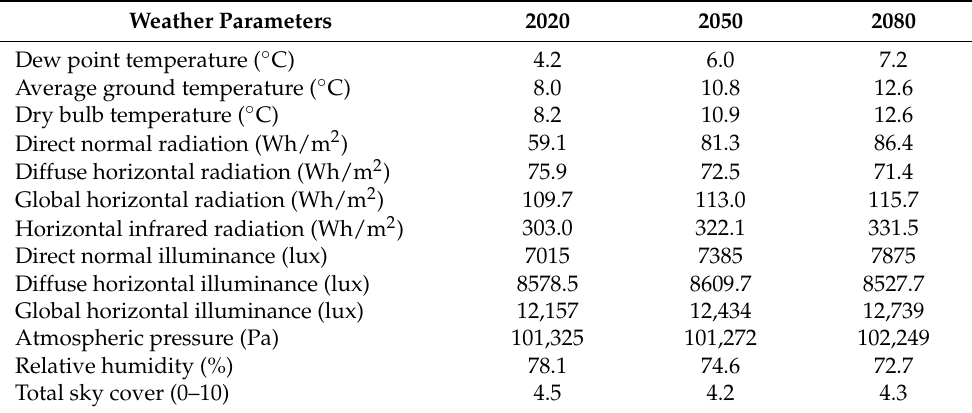
Table 4. Relative changes of weather parameters for 2050 and 2080 compared to